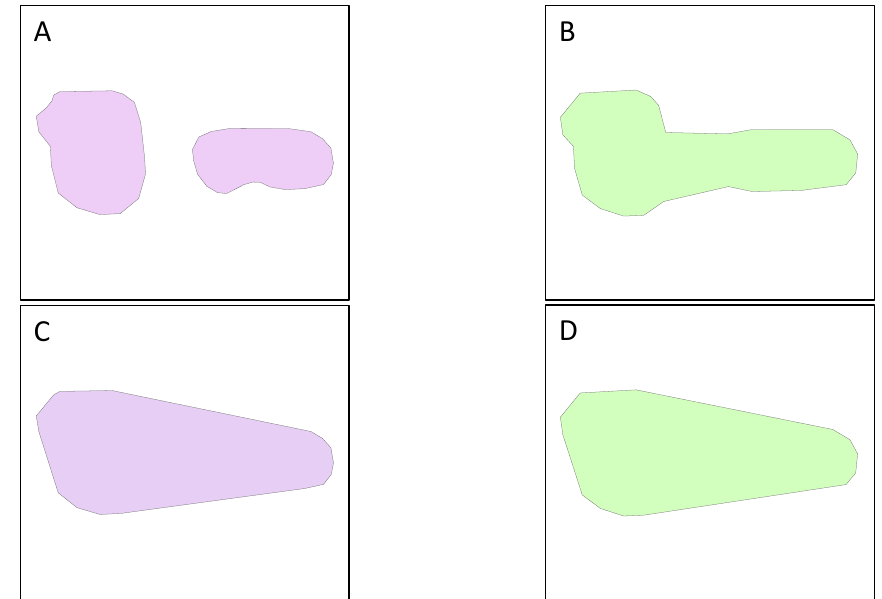
( d ) Figure 1. Qinghai Lake in multiple representations ( a ) Simple polygon, ( b ) holed polygon, ( c ) multipolygon; and ( d ) Bing maps. Affected by map generalization, shapes of the same areal entities may differ in multiscale data, while their convex hulls change slightly compared with shapes (Figure 2). In addition, convex hulls can combine disjoint regions into single region, which is convenient for the comparison between multipolygons and simple polygons or multipolygons and holed polygons. Convex hull is also a basic method of multi-scale representation of vector data [26]. Thus, we can use convex hull to extract boundary feature of vector polygons. On the other hand, convex hull can only describe the rough shape of polygons. Areal entities with totally different shapes may also have similar convex hull (Figure 3). Thus, it is necessary to find a shape similarity measurement to combine region-based shape descriptor with convex hull. Through the combination method, the same entities will have a higher similarity while different entities will have a lower similarity. There are many investigations